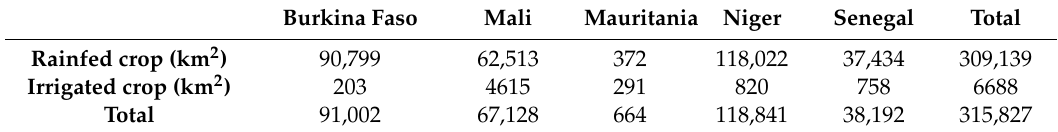
Figure 7. The relative importance (%) of the five Sahelian countries in cropland area across West Africa, showing total cropland area, rainfed and irrigated croplands, and the comparison of rainfed and irrigated cropland area as a fraction of the total. Table 4. Estimated area classified as cropland in each of five Sahelian